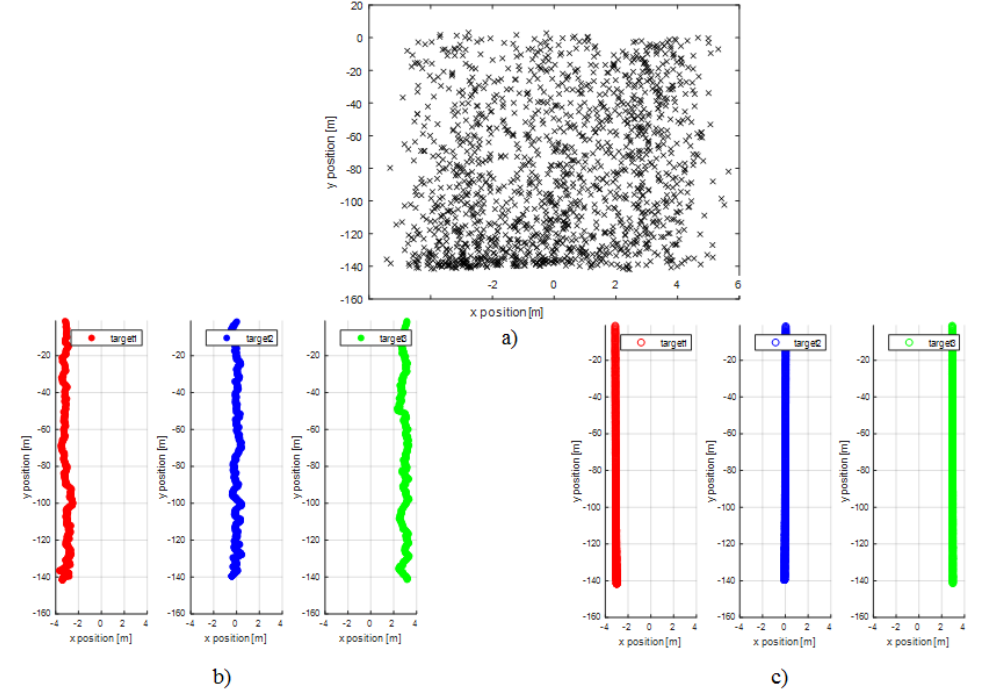
Figure 3. Partial and final results of the first experiment with simulated data, [6]: ( a ) spatial spreading of targets; ( b ) the cumulative effect of data association and Kalman filtering; ( c ) the effect of the explicit polynomial fitting method.